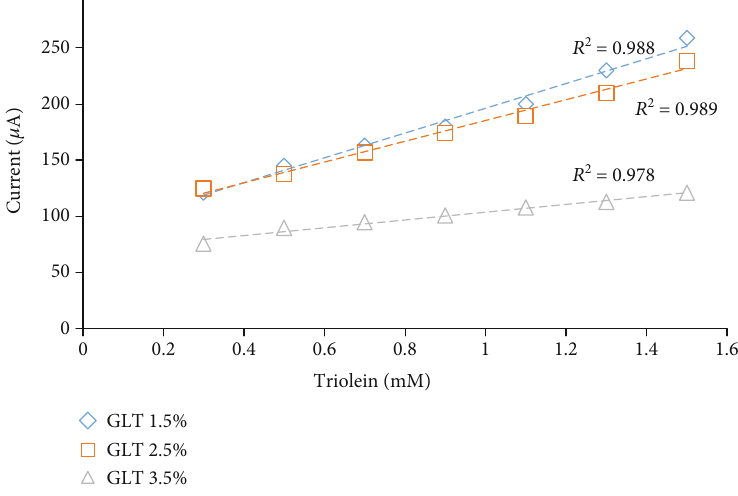
Figure 4: The e ff ect of glutaraldehyde content on biosensor